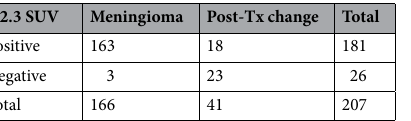
Table 3. Contingency table for the SUV method at the pre-determined threshold of 2.3.